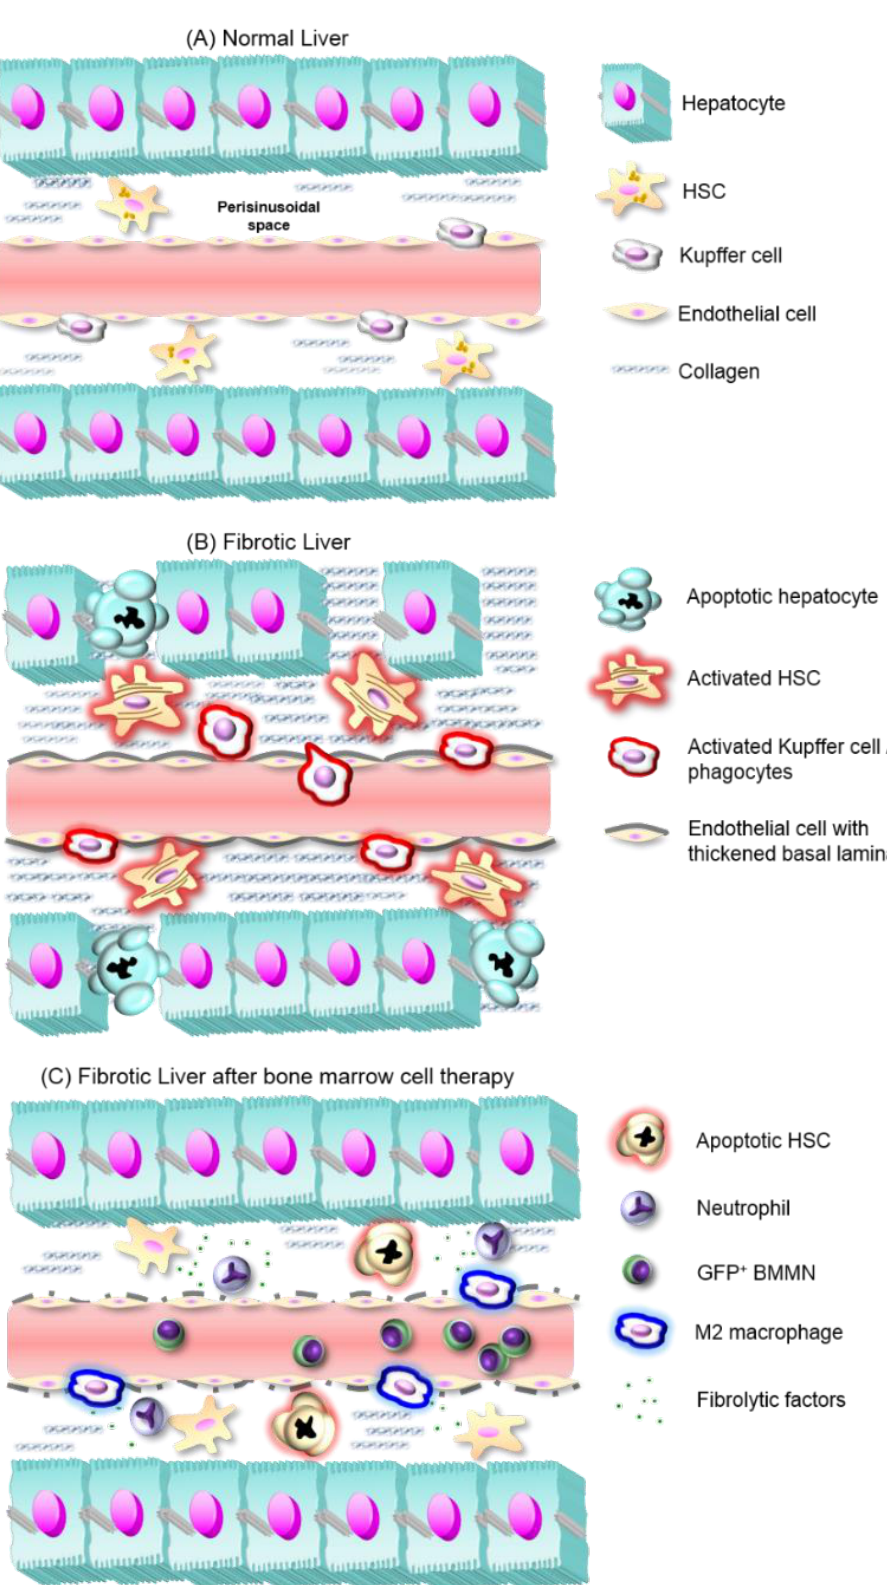
Figure 1. Liver fibrosis development and proposed mechanisms of fibrosis reversal by BMMNs. ( A ) In normal liver, hepatocyte plates line sinusoidal capillaries and between both structures